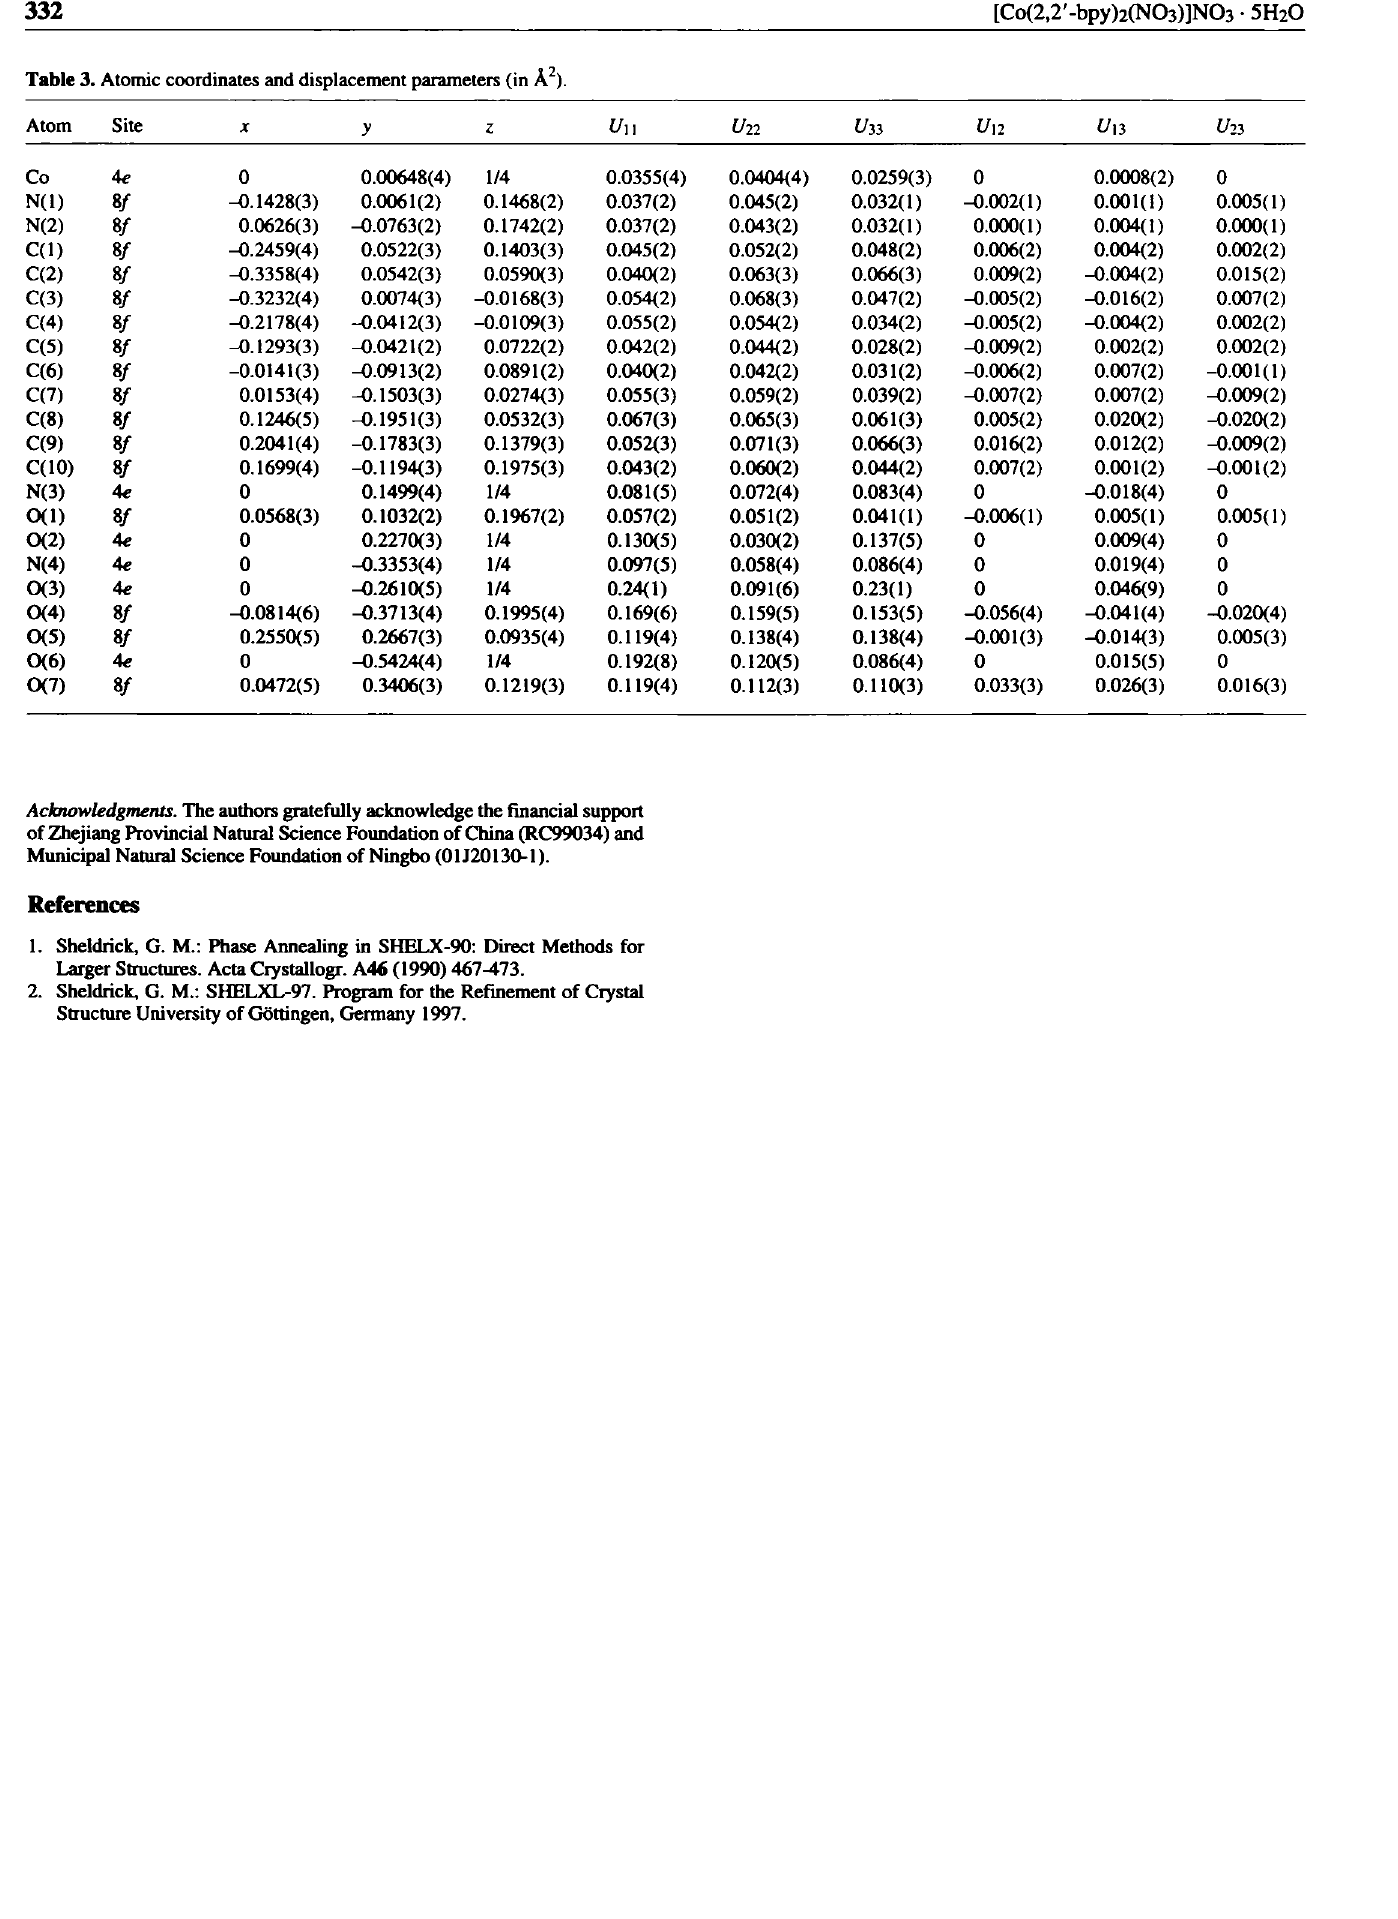
Table 3. Atomic coordinates and displacement parameters (in Ä 2